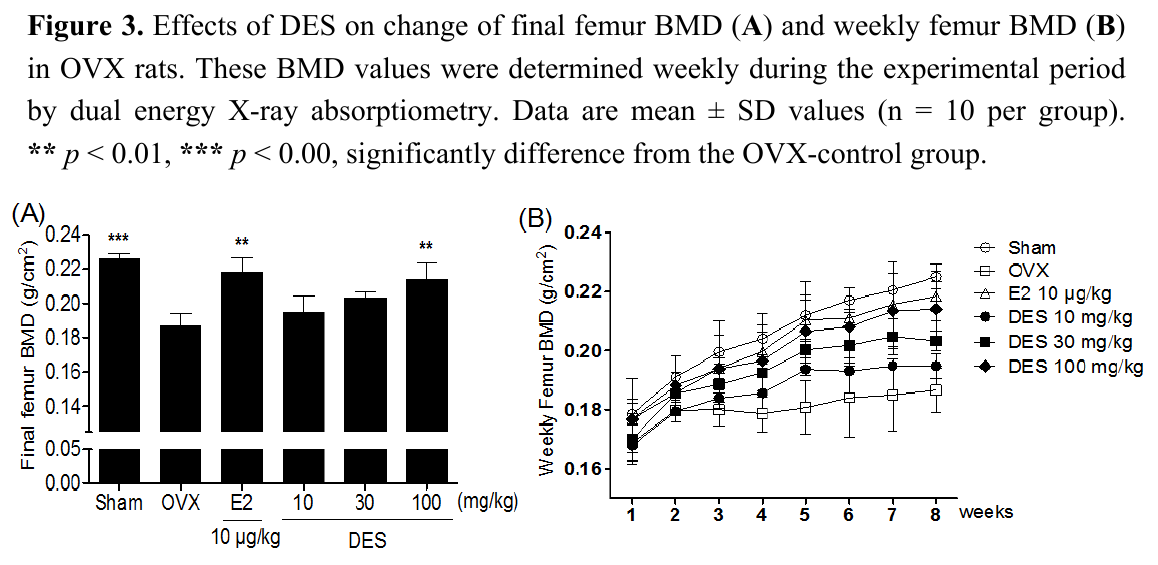
Figure 3. Effects of DES on change of final femur BMD ( A ) and weekly femur BMD ( B